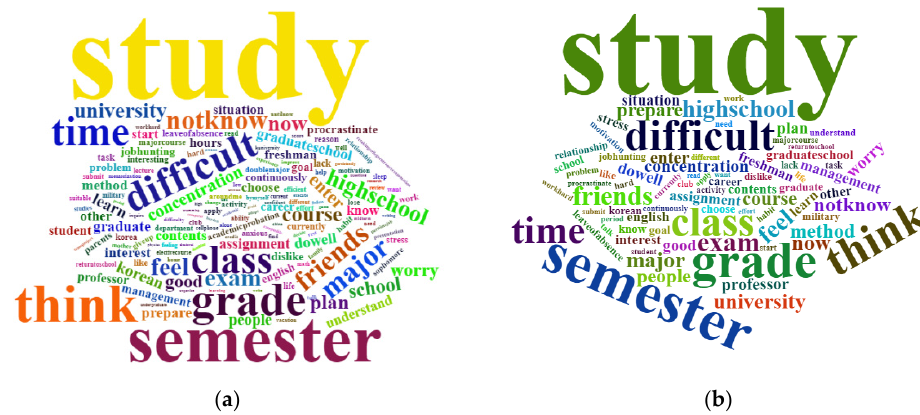
Figure 1. ( a ) Wordcloud of keywords for HSS track; ( b ) Wordcloud of keywords for STEM track.